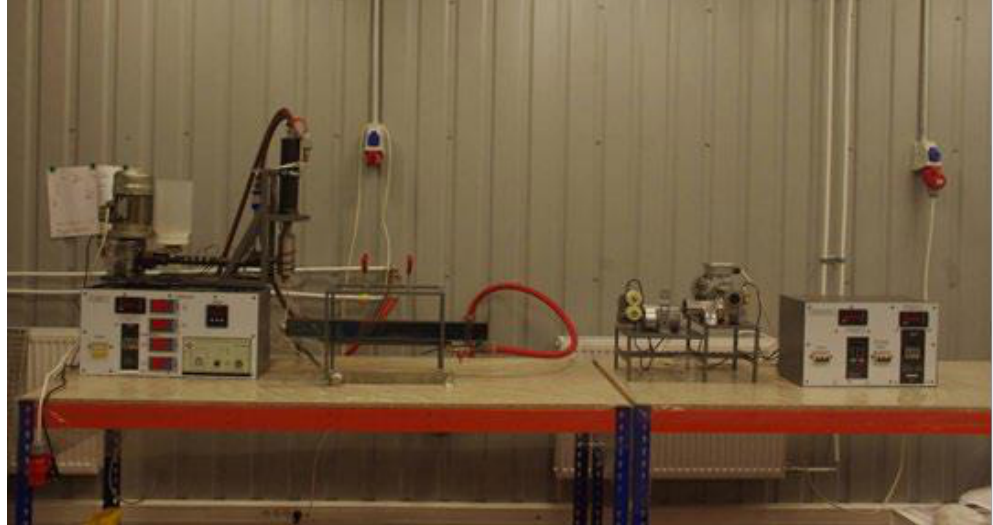
Figure 2. Laboratory extruder with ultrasonic melt treatment.